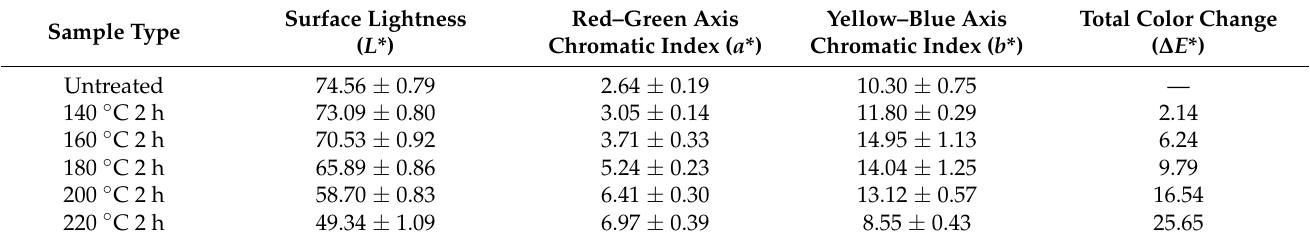
Figure 2. Color change of bamboo fiber after vacuum heat treatment. Table 1. Color parameters of vacuum heat-treated bamboo fiber.